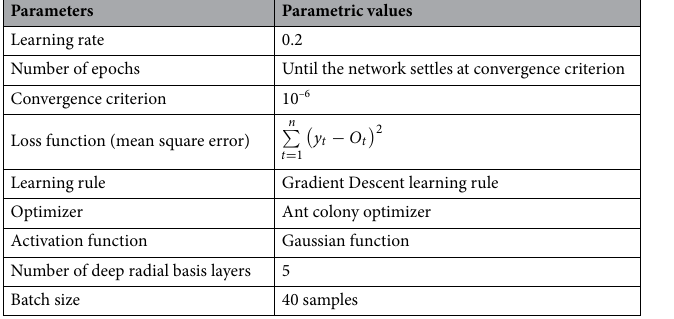
Table 3. Parameters of the proposed deep neural